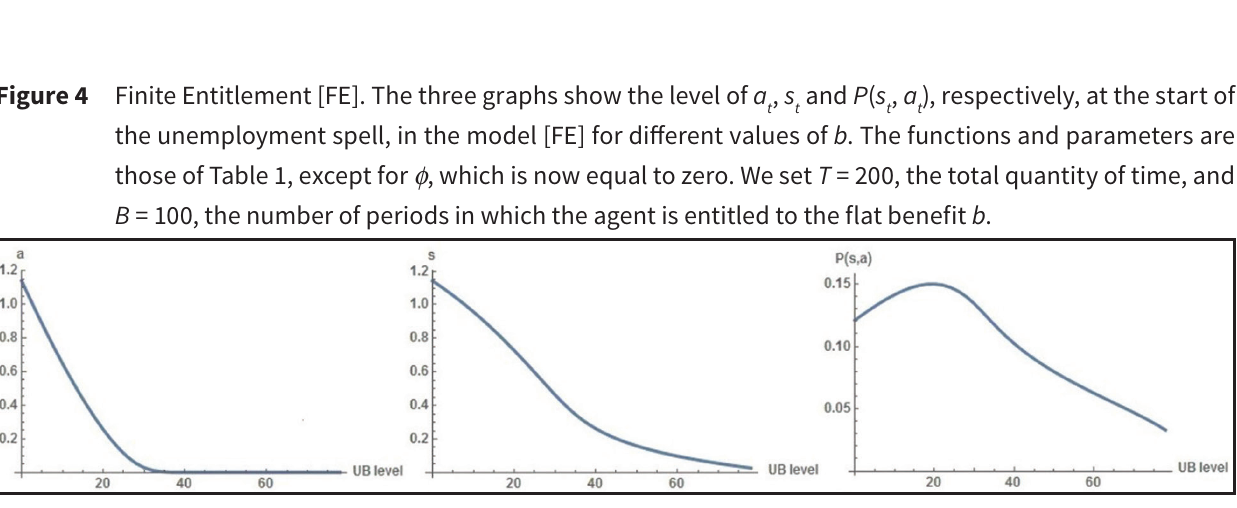
, s and P ( s , a ), respectively, at the start of t t t t